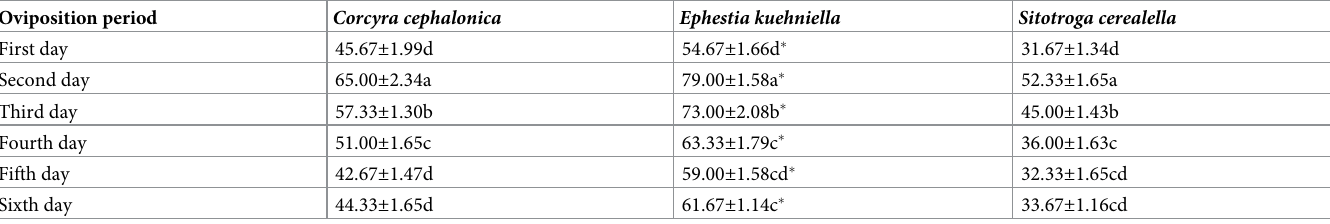
Means ± SE in the same column followed by the same letter did not significantly differ according to the Kruskal–Wallis test (p > 0.01). � indicates a significant difference between values in the same row as per one-way ANOVA ( P <